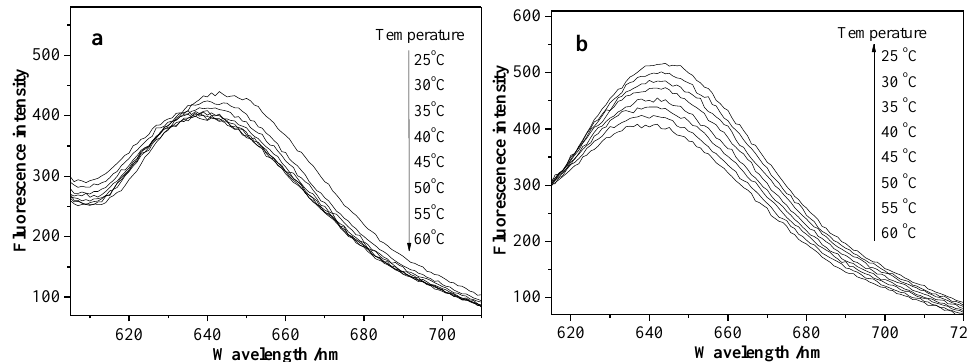
Figure 12. Fluorescence spectra of NR-S3 micellar solution at the heating process from 25 to 60 ◦ C ( a ) and the subsequent cooling process from 60 to 25 ◦ C ( b ).